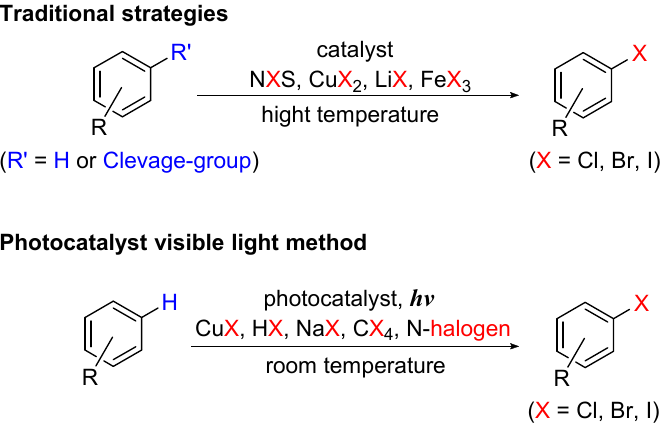
Scheme 37. Synthetic methods for halogenation of aromatic C-H